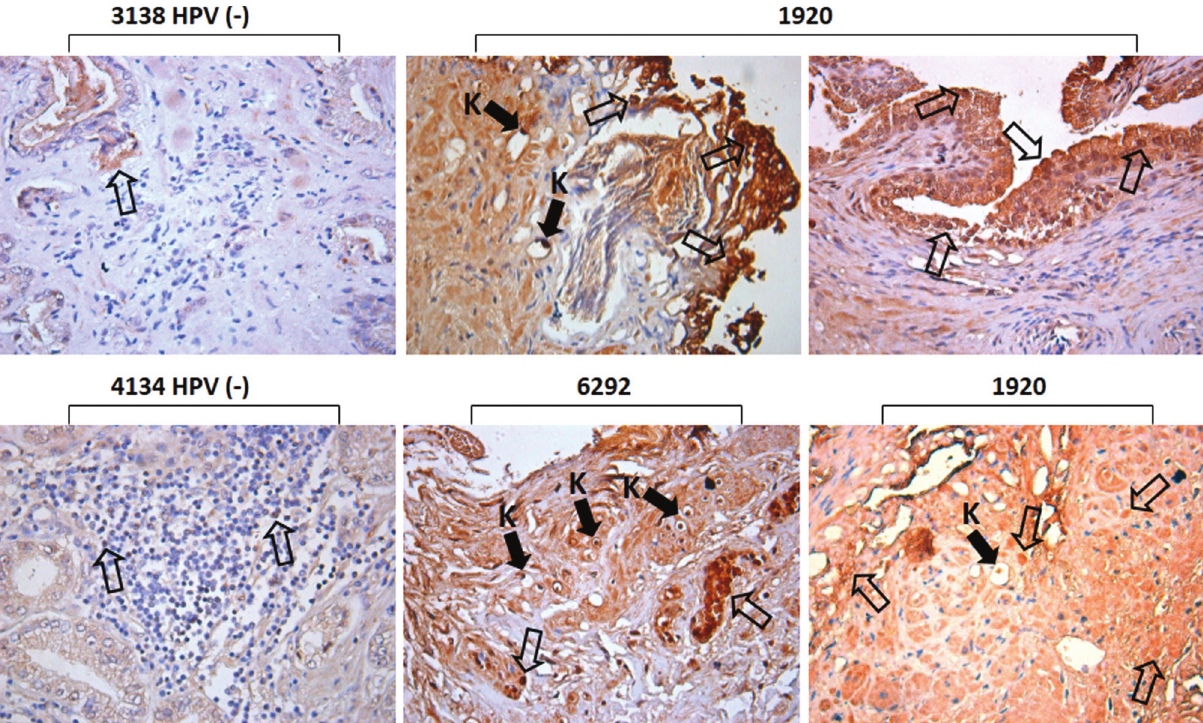
Figure 3 - Immunohistochemical detection of p16INK4A in prostate cancer. A strong positive (empty arrows) signal of p16INK4A protein was detected in HPV-positive tissues compared with HPV-negative [HPV(-)] tissues. Solid arrows indicate a positive signal of p16INK4A in koilocytes (K). Magnifi- cation: 40 (cid:2) . The numbers indicate the control number of each